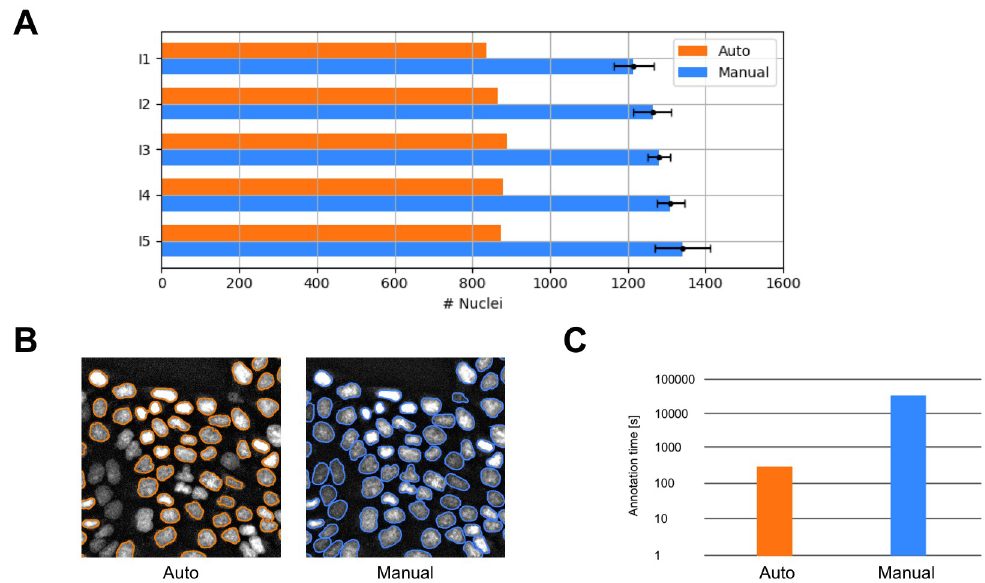
Fig 3. Performance of automated and manual nuclei annotation. A: Number of automatically and manually annotated nuclei for a dataset of five images (I1-I5). B: Regions of interest provided by automatic and manual nuclei annotation. C: Annotation duration of a dataset containing 6409 fluorescently labelled nuclei with automatic (~5 minutes) and manual data annotation (~15 hours).